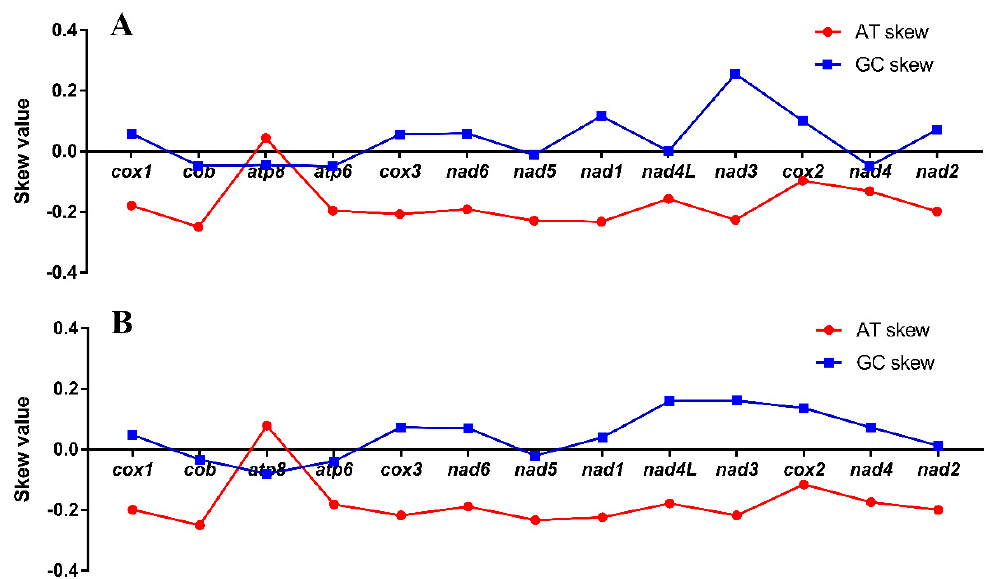
Figure 5. Graphical illustration showing the AT and GC skew in the protein-coding genes (PCGs) of ( A ) P. bilineatus and ( B ) M. bilineatus . Genes 2019 , 10 , 198 ( A ) P. bilineatus and ( B ) M. bilineatus .